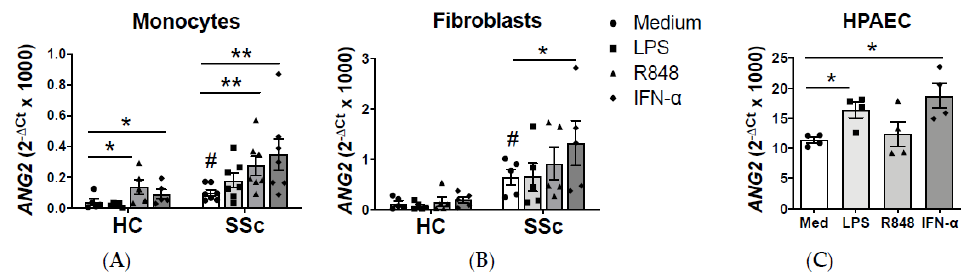
Figure 2. Ang-2 levels are elevated in monocytes and dermal fibroblast of SSc patients. ( A – C ) ANG2 mRNA expression in monocytes ( A ) and dermal fibroblasts ( B ) from HC and SSc patients ( n = 5–6) from HPAECs ( C ) stimulated with lipopolysaccharide (LPS) LPS, R848 or interferon alpha2a (IFN- α ) for 24 h ( n = 4). Means and SEM are shown. * p < 0.05 and ** p < 0.01. # p < 0.05 compared to HC medium.